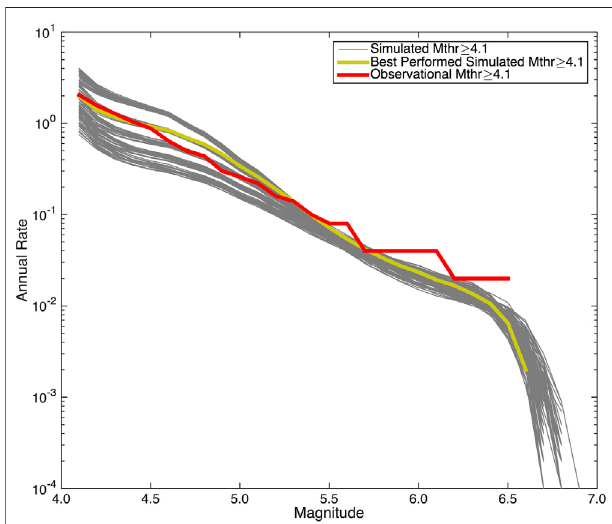
FIGURE 5 | Summary of annual occurrence rates of the 105 simulated catalogs (gray lines), using different combinations of the free input parameters ( A σ , S-R , A-R ; Supplementary Appendix A1 ). Annual occurrence rates of the best performed simulated catalog (Simulation 79; A σ (cid:1) 0.035 MPa, S-R (cid:1) 0.15, A-R (cid:1) 2) is represented by the yellow line, and the rates of the observational catalog with the red line.